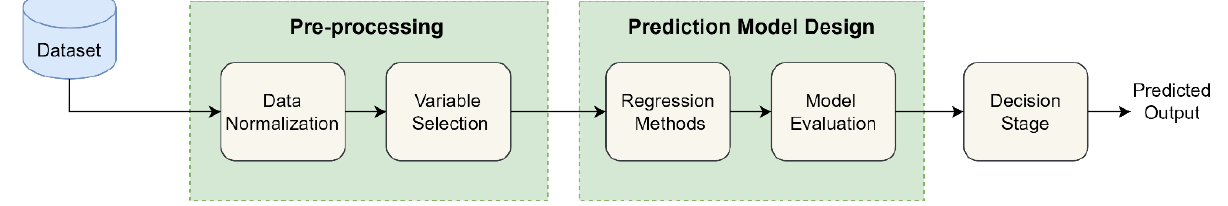
Figure 3. Block diagram of the proposed approach for prediction of undrained shear strength.